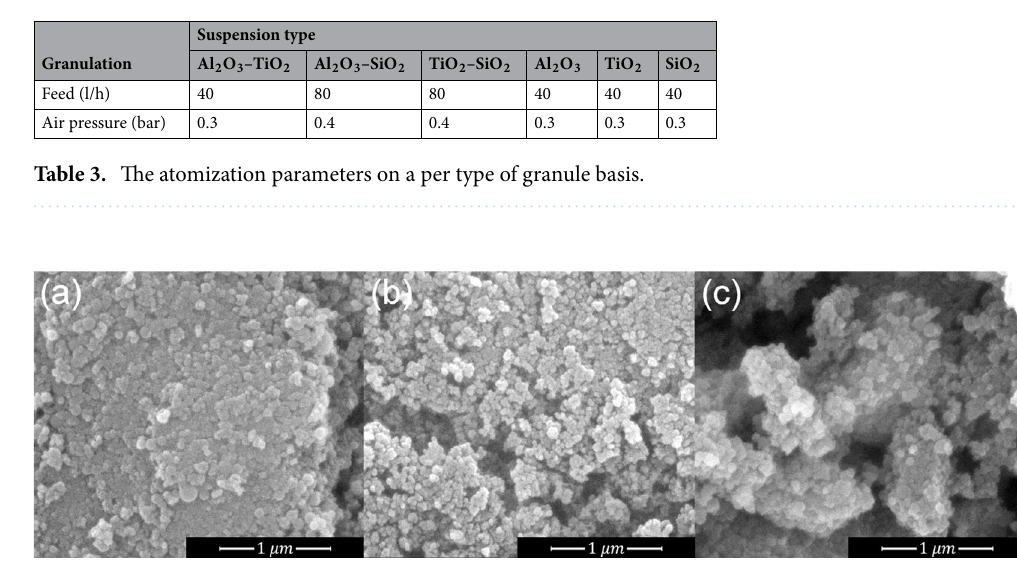
Figure 1. SEM micrographs of the freeze dried heterogenous granules: ( a ) Al 2 O 3 –SiO 2 , ( b ) TiO 2 –SiO 2 and ( c ) Al 2 O 3 –TiO 2